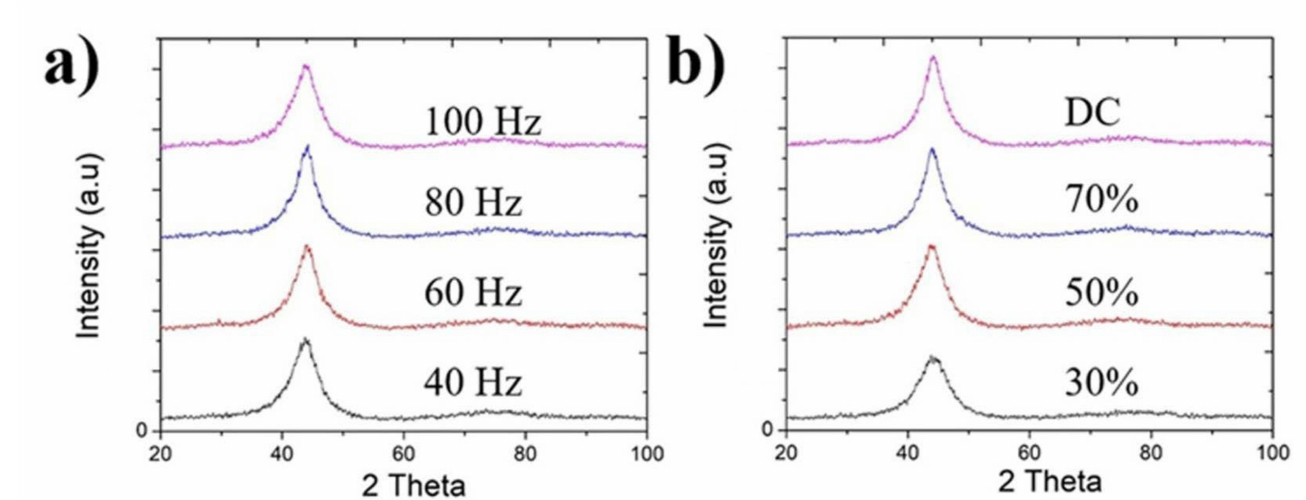
Figure 6. X-ray diffraction (XRD) patterns of coatings with ( a ) varying frequency from 40–100 Hz at